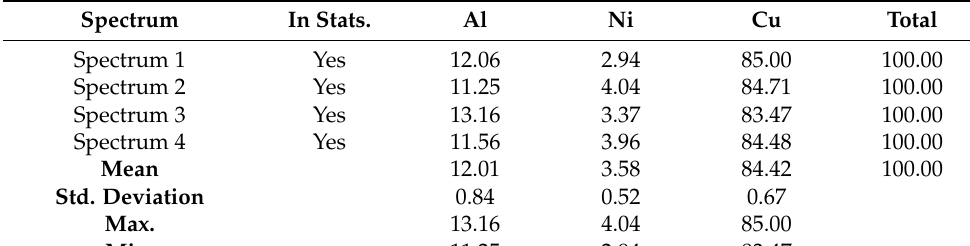
Table 2. EDX chemical composition of the phases in the Cu-Al-Ni rod (in wt.%).